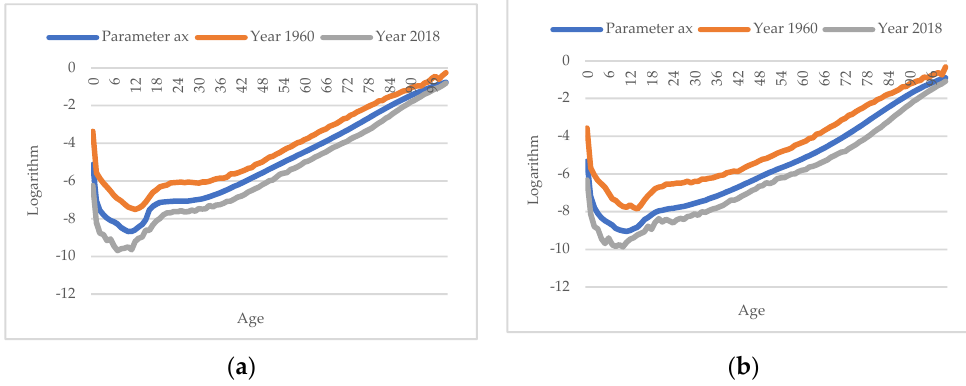
Figure 2. ( a ) Values of the a x parameter according to the age for the Japanese male population and gross values of the mortality rates of the extreme calendar years; ( b ) values of the a x parameter according to the age for the Japanese female population and gross values of the mortality rates of the extreme calendar years. Source: authors